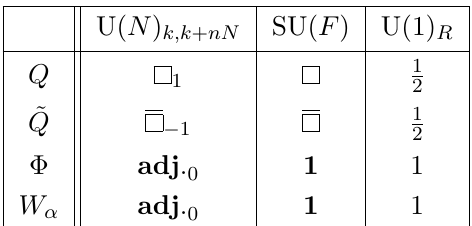
Table 1 . The 3d N = 3 U( N ) k,k + nN gauge theory with F fundamental hypermultiplets in the 3d N = 2 notation. The theory consists of F (anti-)fundamental and one adjoint chiral superfields in addition to the U( N ) k,k + nN vector